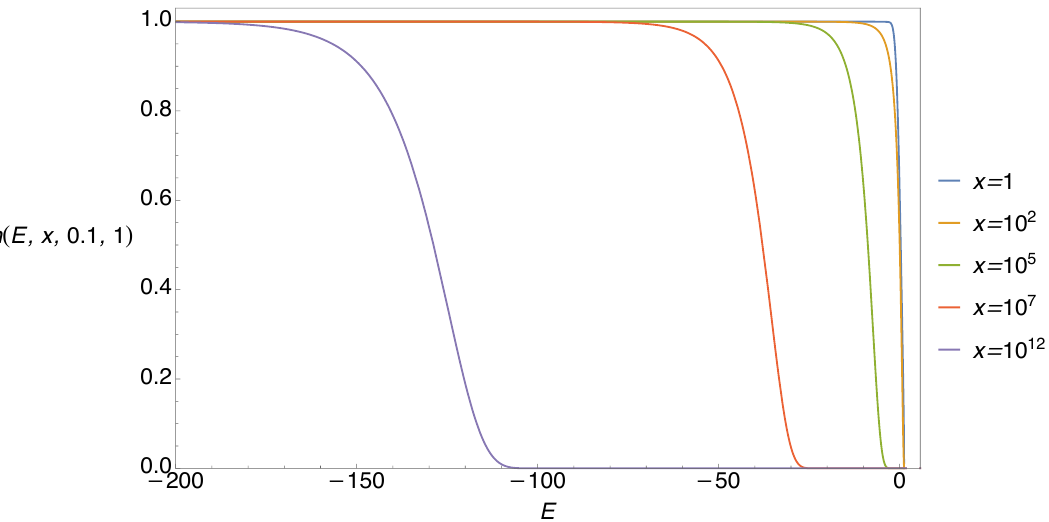
Figure 13. The graph of h against E monotonically shifts to the left when x is sufficiently large. We set λ = 0 . 1 and T = 1